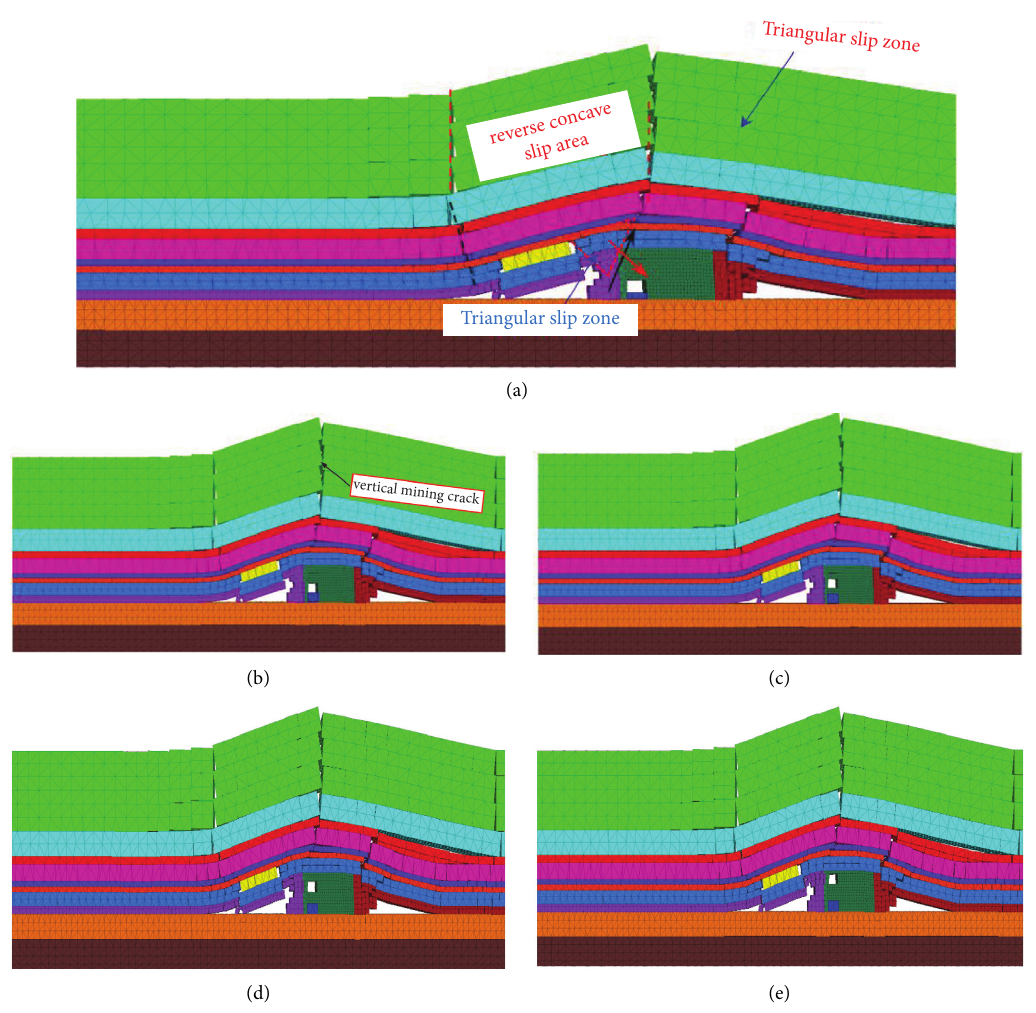
Figure 9: Overlying migration caused by mining in the 30503 working face. (a) H �− 2m. (b) H � 0m. (c) H � 2m. (d) H � 4 m. (e) H �